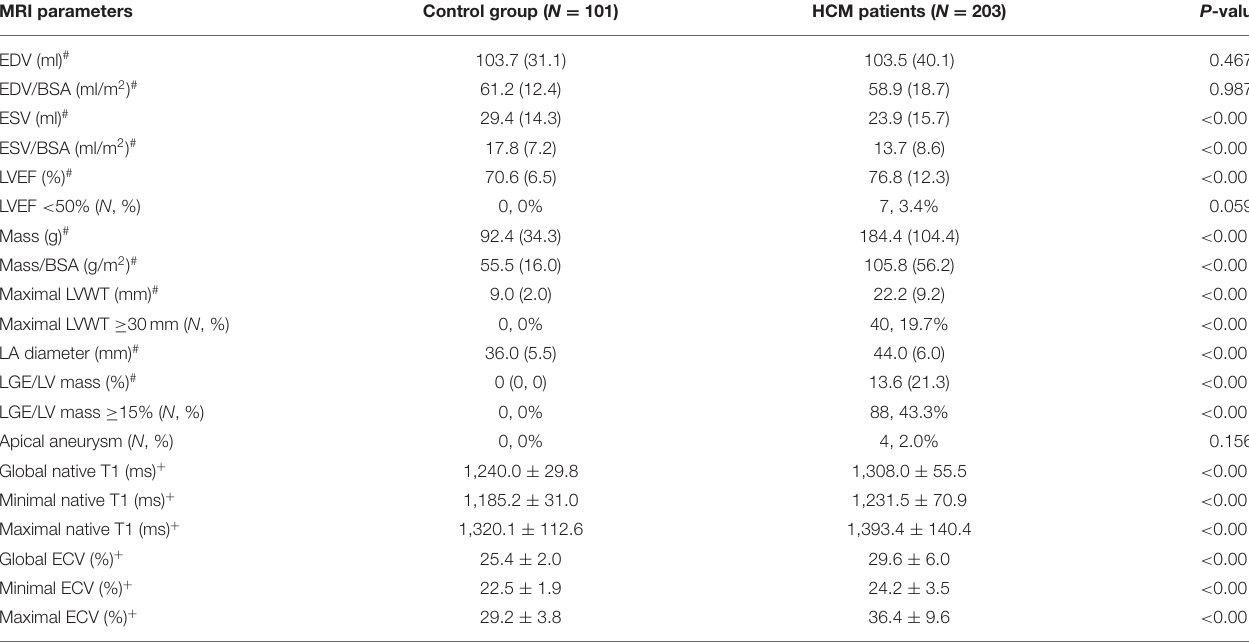
TABLE 2 | Comparison of cardiac MRI data among healthy individuals and HCM patients.